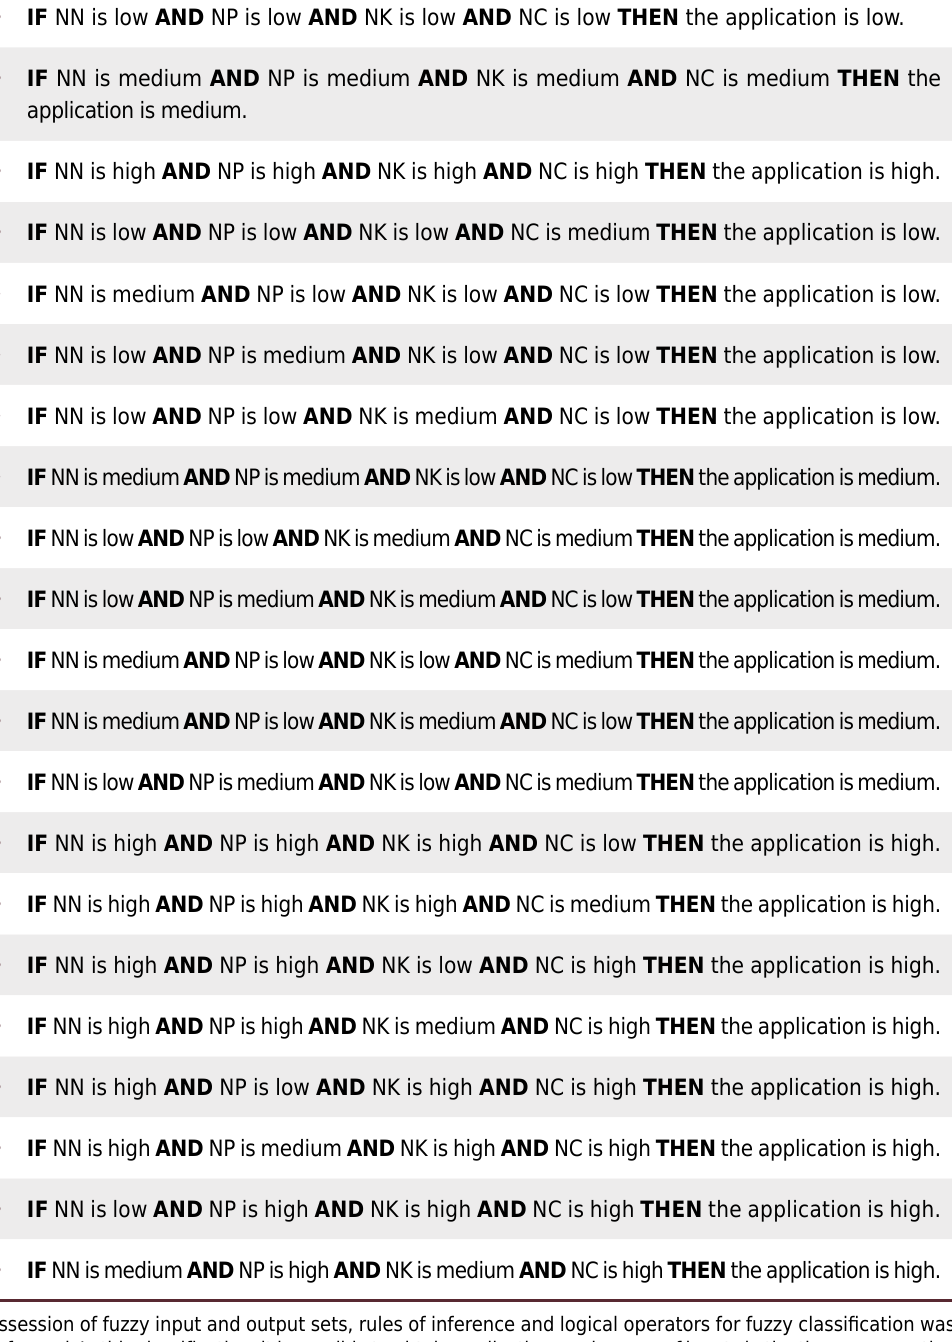
Table 2. Fuzzy inference